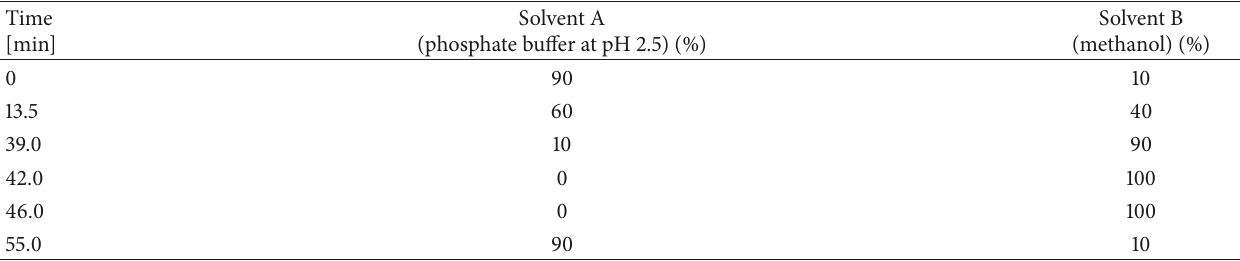
Table 1: Gradient elution profile for HPLC-PAD analysis.